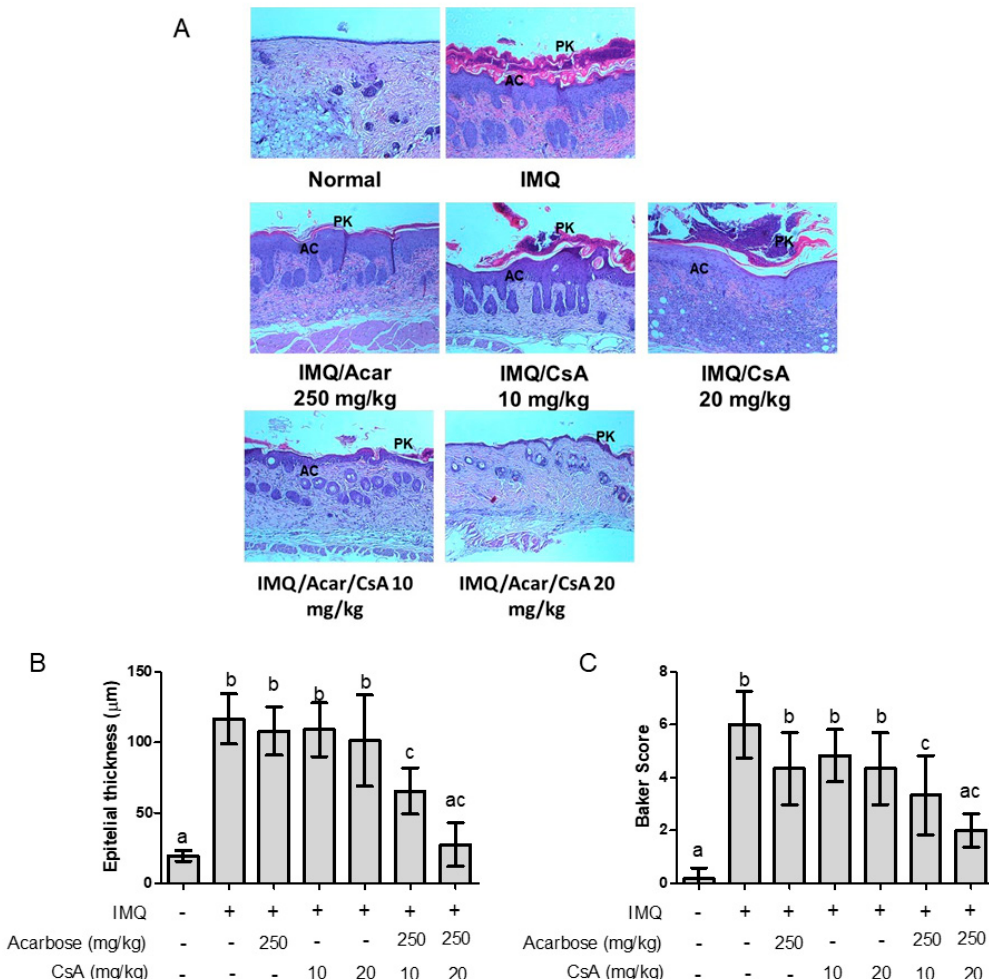
Figure 3. Effects of Acar (250 or 500 mg/kg) and/or low-dose CsA (10 or 20 mg/kg) on ( A ) histological features of skin lesions, ( B ) epithelial thickness, and ( C ) baker score of mice with IMQ-induced psoriasis-like dermatitis. IMQ-treated mice and control mice received a daily dose of 62.5 mg of IMQ cream and control cream, respectively, on shaved back skin for 9 days consecutively. IMQ-treated mice were randomly assigned to the following six groups ( n = 6): IMQ alone, Acar (250 mg/kg/day), CsA (10 mg/kg/day), CsA (20 mg/kg/day), Acar (250 mg/kg/day) + CsA (10 mg/kg/day), and Acar (250 mg/kg/day) + CsA (20 mg/kg/day). Acar was administered to the mice orally once a day for 9 days consecutively by gavage in 200 μ L of water, either alone or in combination with CsA. Experimental data are expressed as mean ± SD ( n = 6). Columns with different superscript letters (a, b, c, ac) are significantly different at p < 0.05.